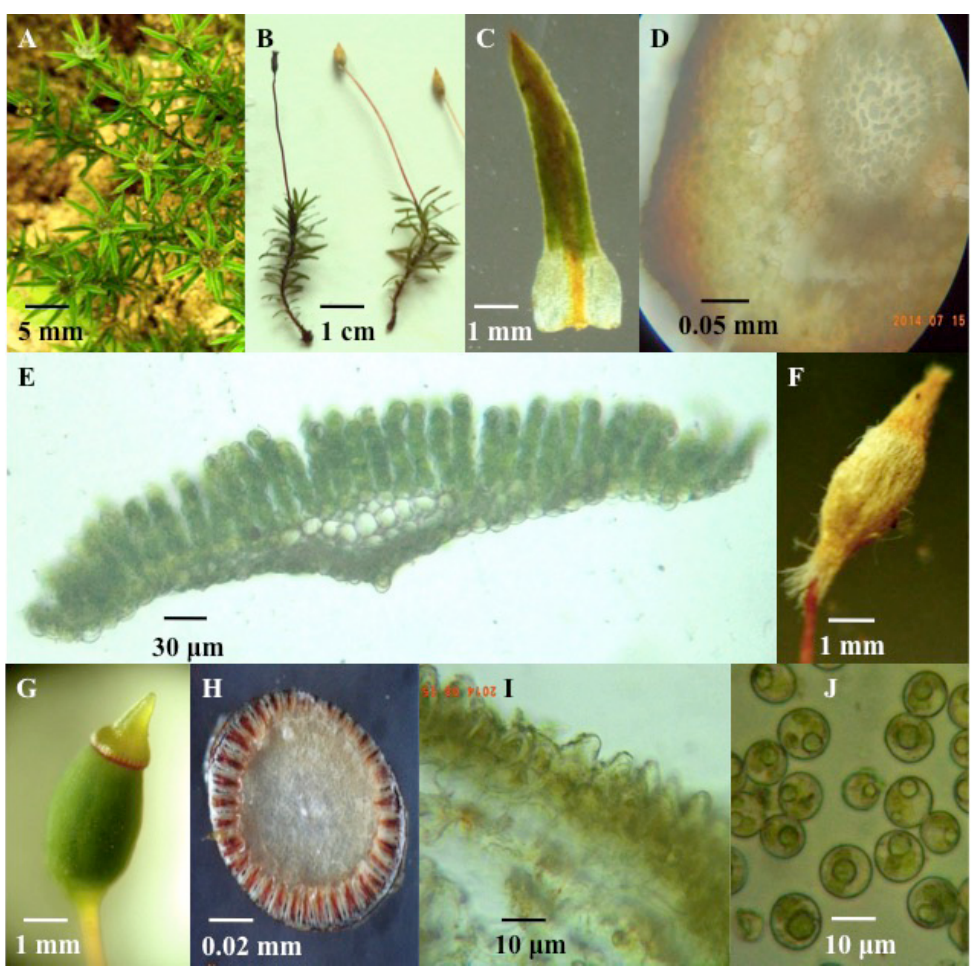
Figure 5: General morphology of Pogonatum (A) male gametophytes with perigonia on the top, (B) female gametophytes with the sporophytes (C) vegetative leaf blade with hyaline sheathing base (D) transverse section of stem (E) transverse section of leaf blade, (F) Hairy calyptra completely covering the capsule (G) capsule with lid, (H) epiphragm (I) part of transverse section of capsule wall, (J)